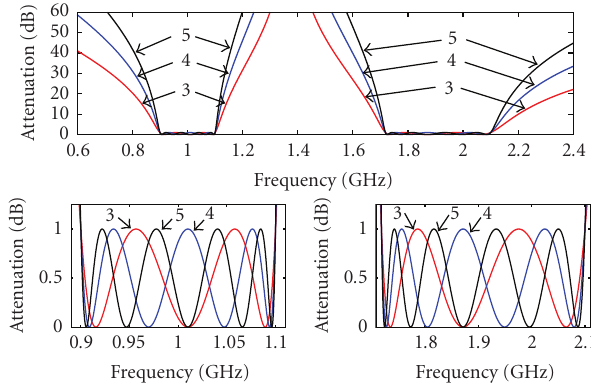
Figure 4: Simulated attenuation responses of the dual-band bandpass filters transformed from 1-dB Chebyshev low-pass filters for filter orders of 3, 4, and 5. (The response of the lower and upper pass bands in the upper subplot is amplified in the left and right bottom subplots, , resp. Here, R